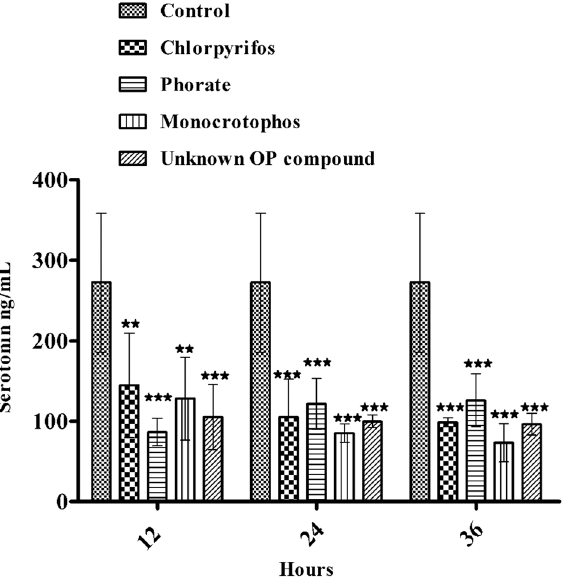
Figure 1. Neurotransmitter levels (serotonin) after acute OP poisoning with chlorpyrifos, phorate, monocrotophos, and unknown OP compounds; serotonin concentrations in human plasma samples from 12 to control group non-OP exposures (N = 05)). * p < 0.05, ** p < 0.01, and *** p < 0.001, compared with the control group. p > 0.05was considered